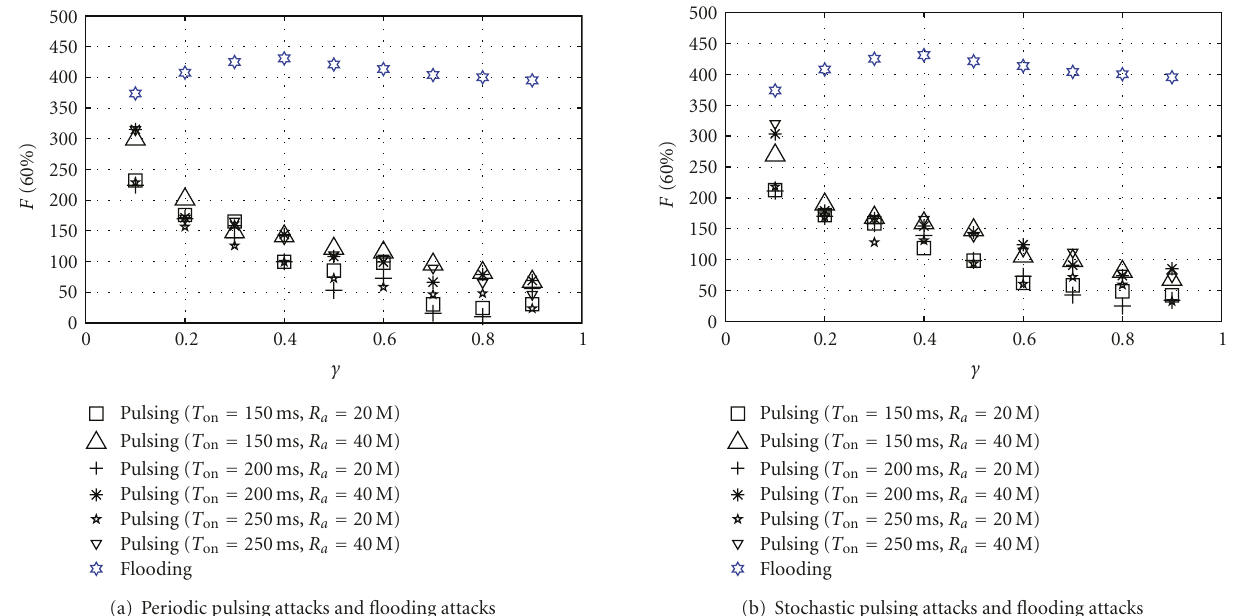
Figure 10: Average detection times for pulsing and flooding attacks using the STM